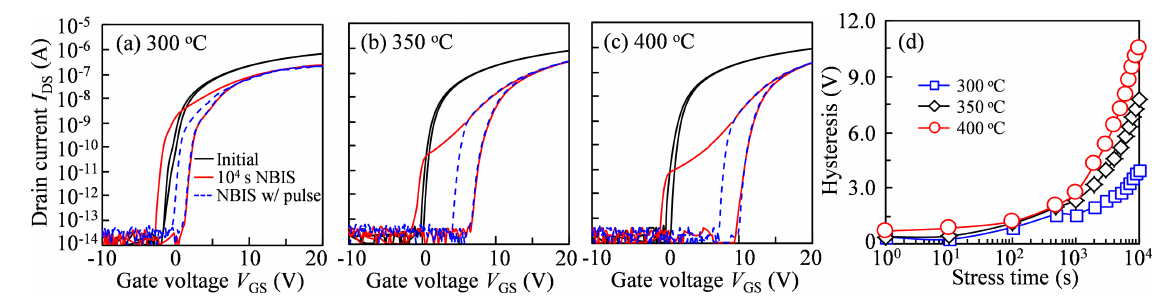
Figure 4: Figure 4 Transfer curves of IGZO TFTs annealed at (a) 300 °C, (b) 350 °C, and (c) 400 °C before and after 10 4 s NBIS without and with a 10 V gate pulse; (d) hysteresis of IGZO TFTs as a function of NBIS duration.